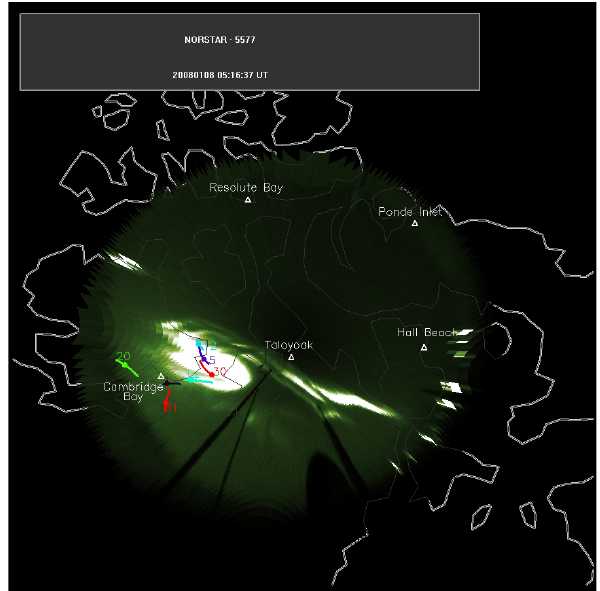
Fig. 4. The 557.7-nm image from 8 January 2008, 05:16:37UT mapped on a geographic grid assuming altitude of 110 km. The IPPs of GPS satellites (PRN numbers) for which cycle slips were observed are superposed for one hour starting at 05:00UT. The dots show IPPs at the time when the image was taken. The PRNs are numbered and color coded as in Fig. 2.